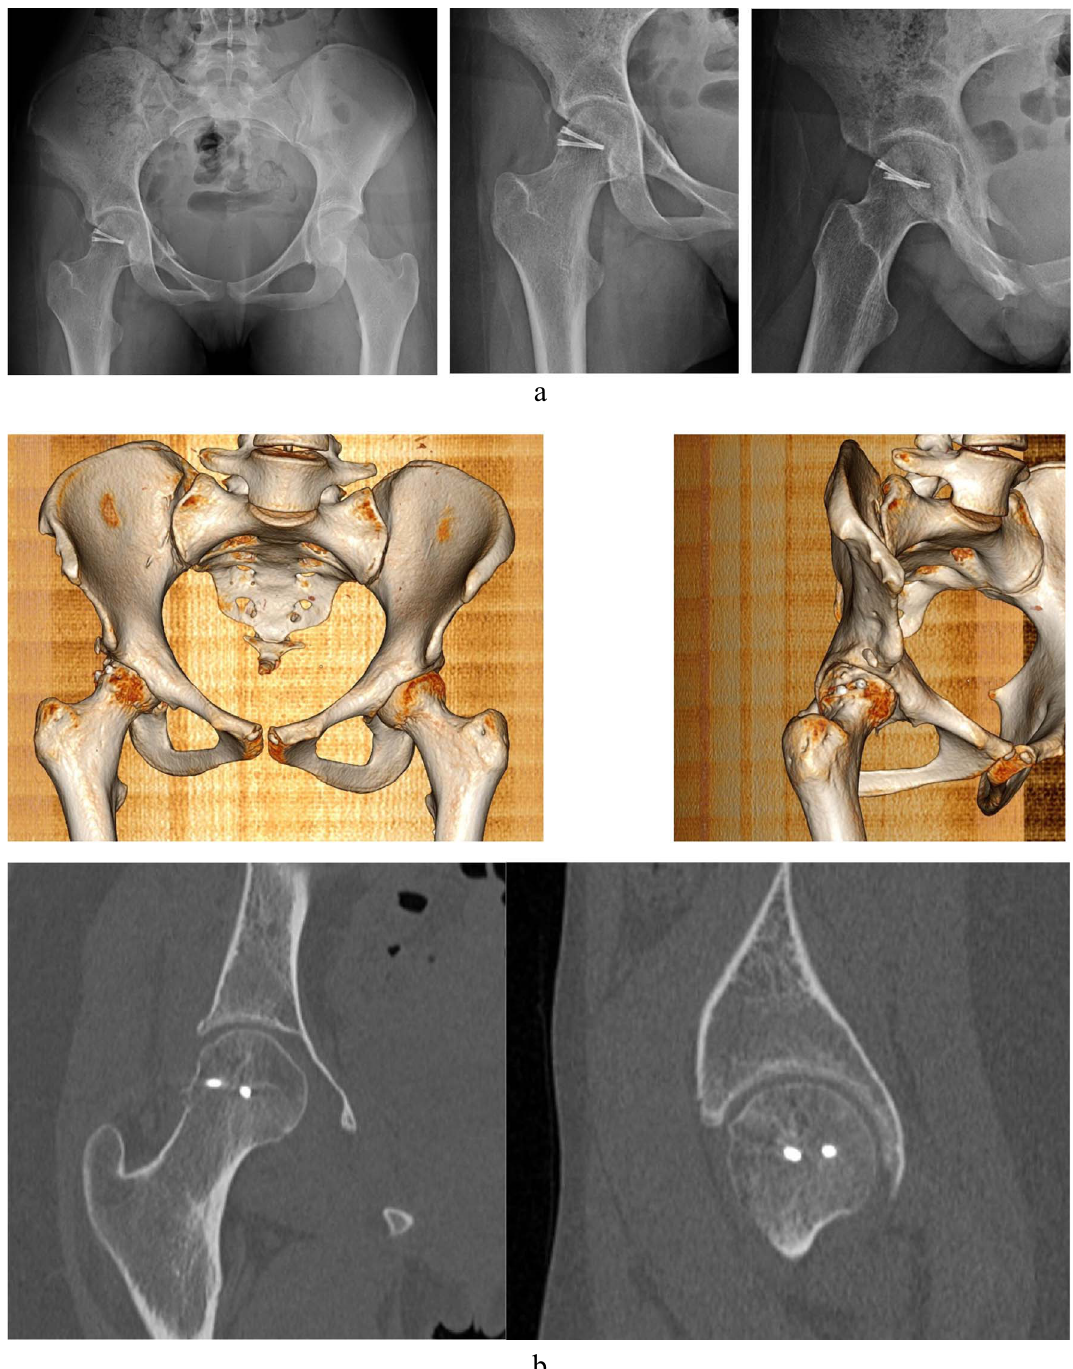
Figure 3. X-ray image of the right hip 3 months after surgery (a) left : pelvic AP, middle : right AP axial, right : external and internal oblique view (b) CT scan 1 year after surgery demonstrating both femoral head screws and a slightly irregular surface with good joint space at the upper part of the femoral